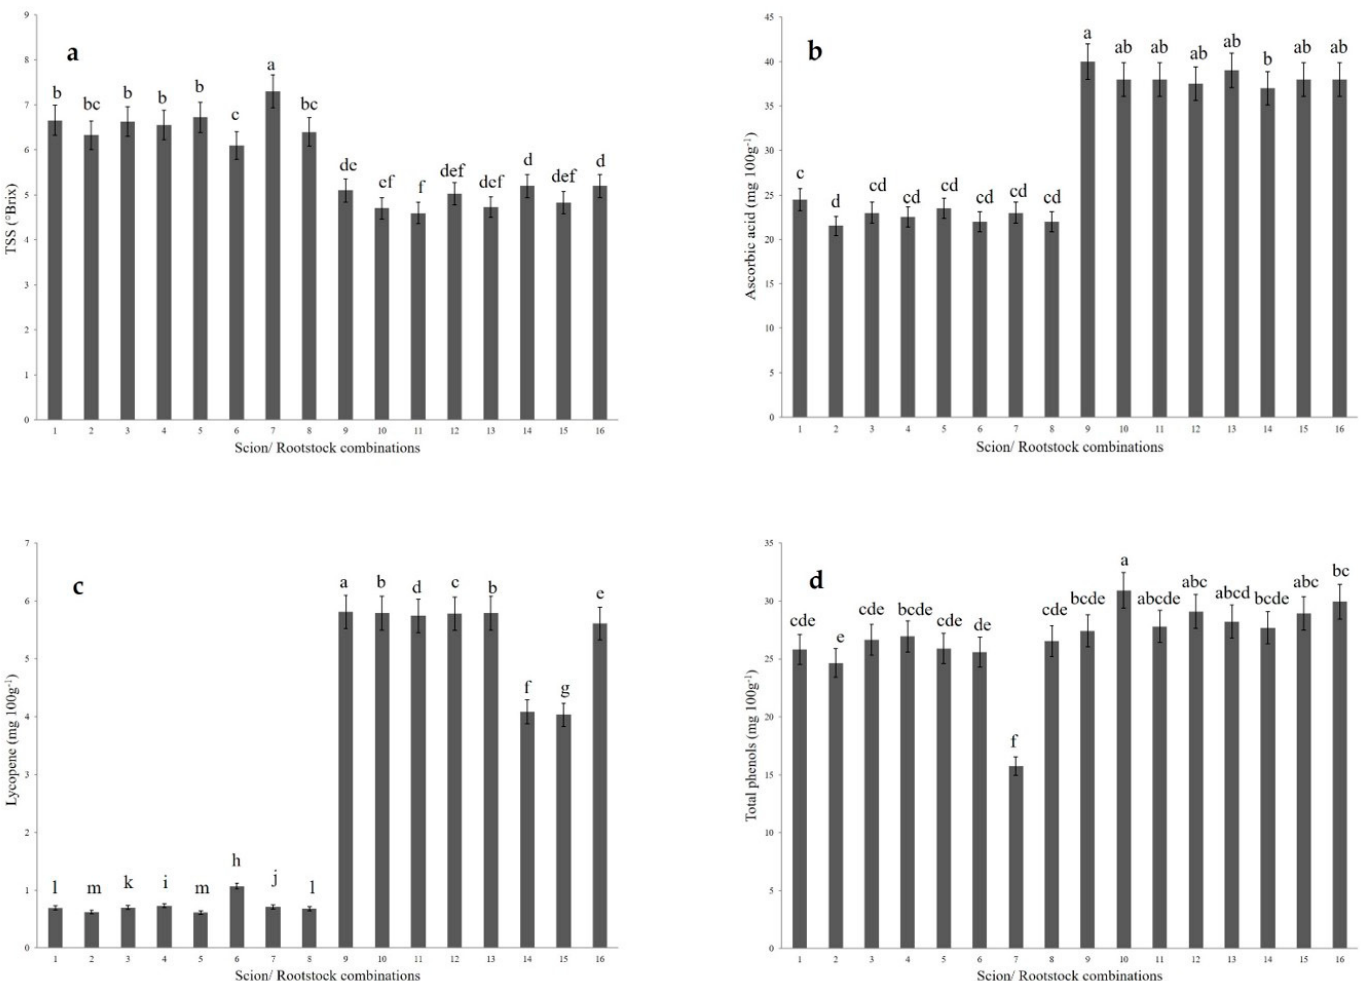
Figure 1. Fruit quality parameters of grafted and non-grafted cherry tomato plants: ( a ) TSS (°Brix), ( b ) ascorbic acid